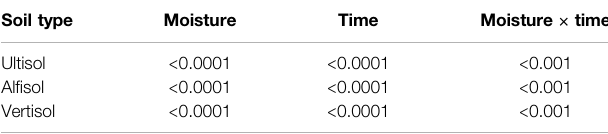
TABLE 2 | Repeated measures ANOVA statistics ( p value) for soil moisture and time effects on microbial respiration. Soil